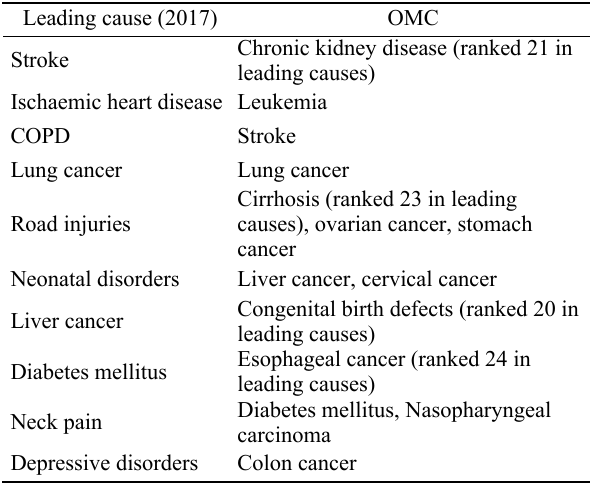
Table 4 Comparison between top causes of death and top illness types in OMC.